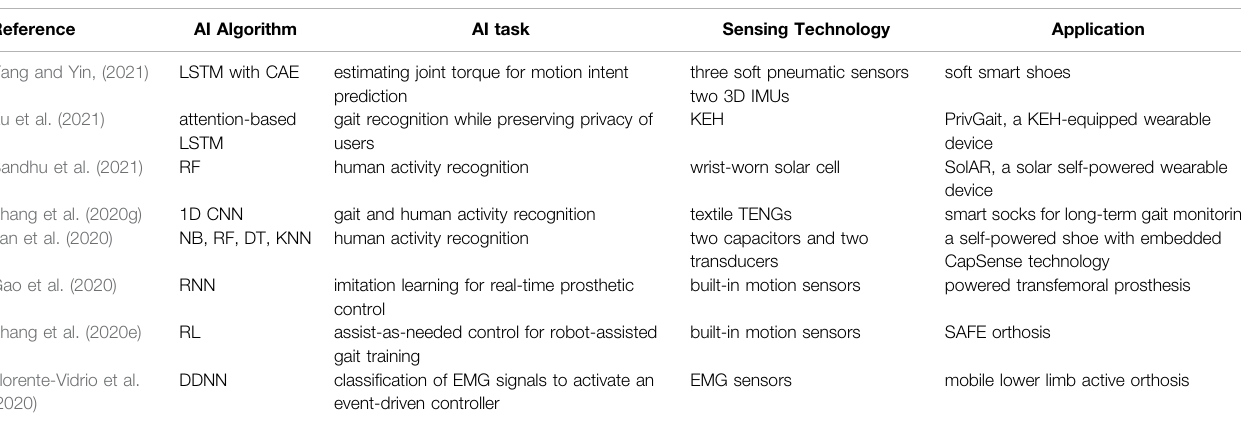
TABLE 12 | Smart gait